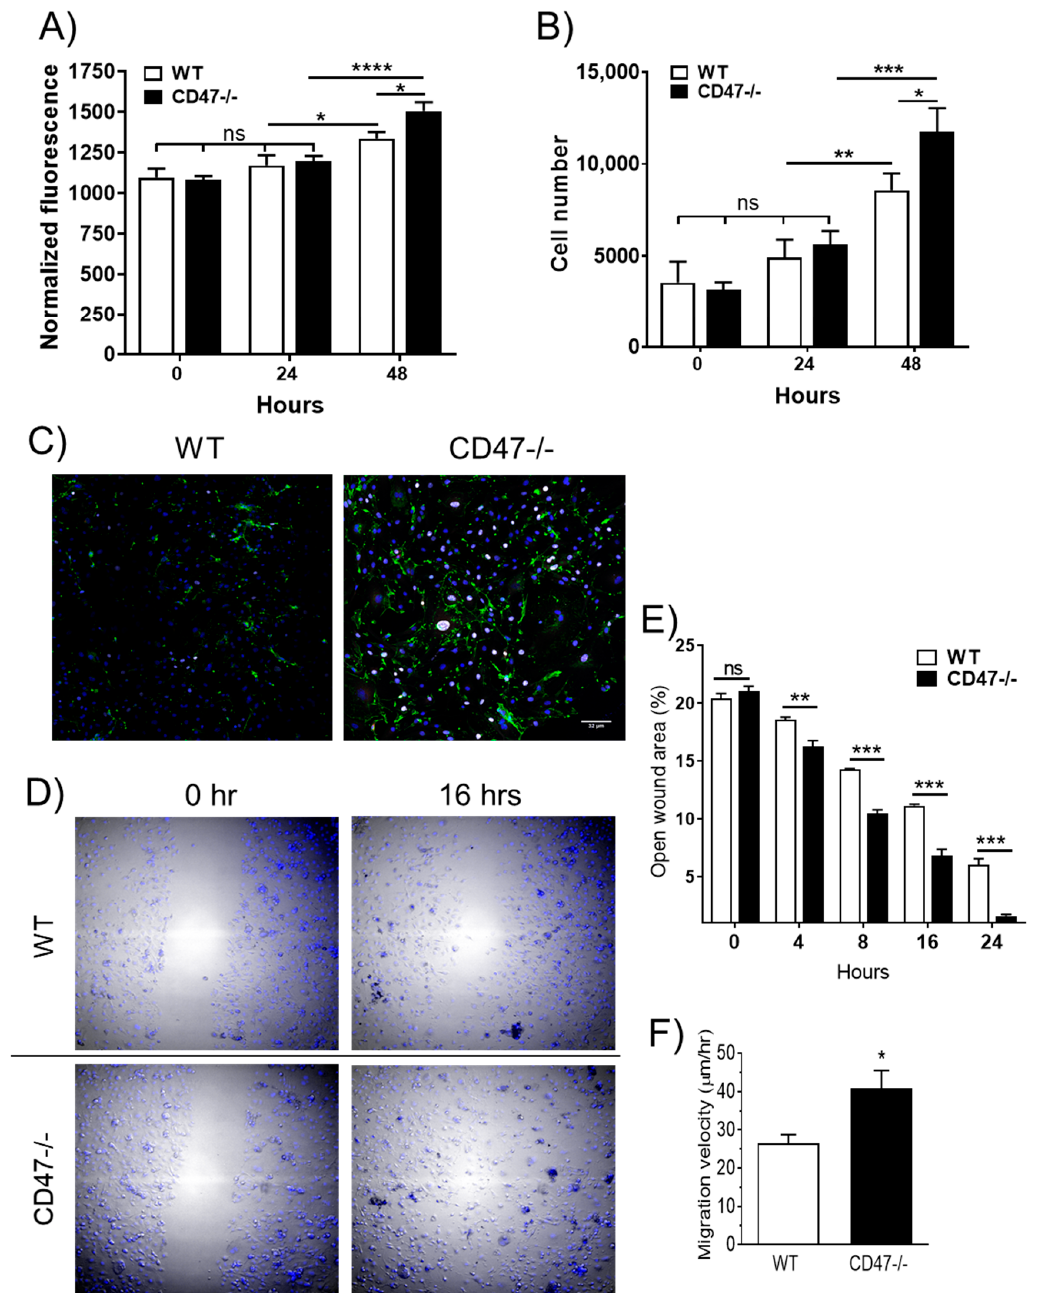
Figure 2. Age-associated decreases in arterial endothelial cell (EC) proliferation and migration are abrogated in the absence of CD47. Aortic ECs from aortas from aged male wild-type (WT) and CD47-null mice were characterized for DNA content using CyQUANT ® fluorescence ( A ) and cell count ( B ). Ki67 immunofluorescence (in white) in arterial ECs of arteries from aged WT and CD47-null mice, von Willebrand factor in green and DAPI in blue ( C ). Representative images of ECs after scratch wounding at 0 and 16 h ( D ). Quantification of the open wound area in respective images ( E ). Quantification of average cell migration velocity ( F ). Scale bar: 32 μ m. Error bars represent the mean ± SEM, samples in triplicate wells. An unpaired t -test was performed with * p < 0.05, ** p < 0.01, *** p < 0.001, ns: non-significant.